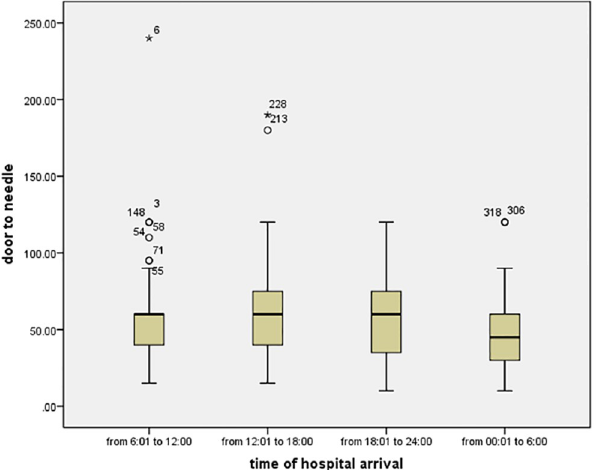
Fig 5. Box plot of door to needle time along the 4 quarters of day according to time of hospital arrival.